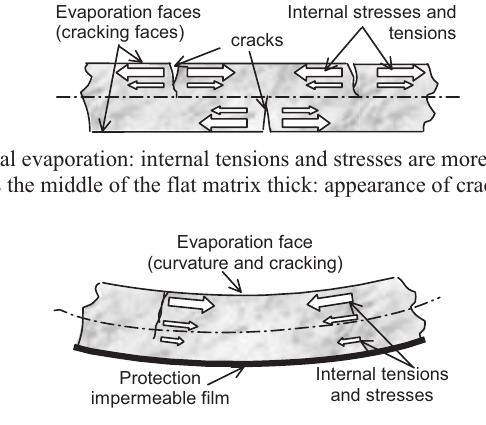
Fig. 10. Internal stresses distribution in a flat matrix thickness during a symmetrical drying (a) and a dissymmetrical drying (b).